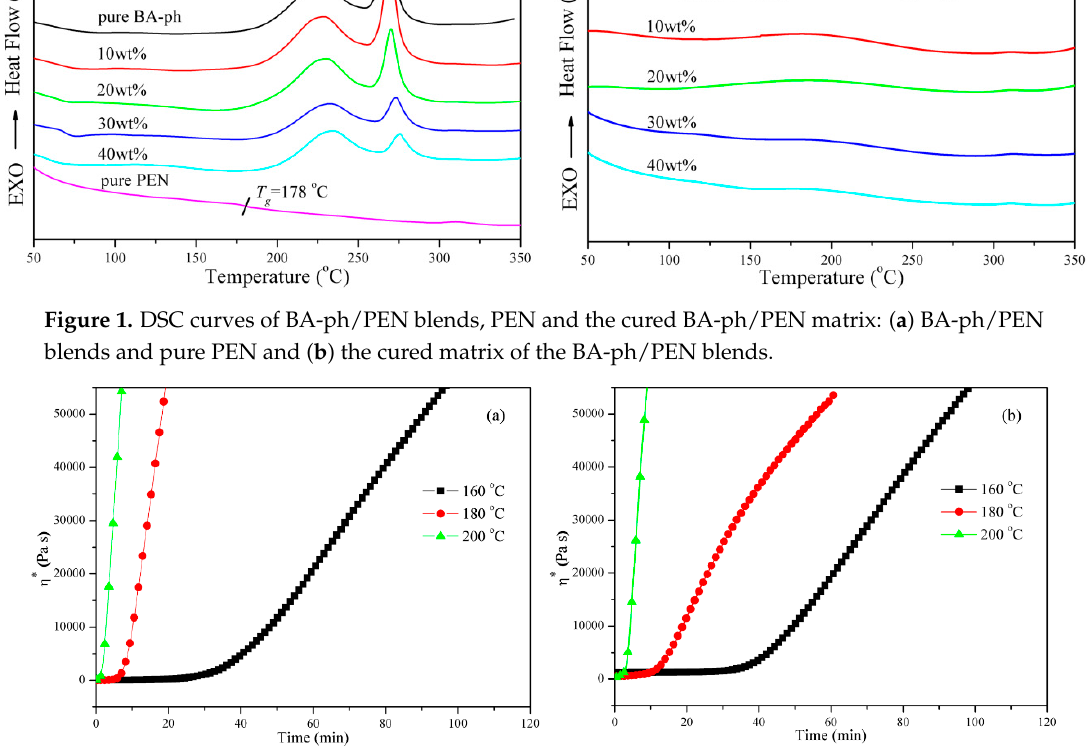
Figure 2. Viscosity of the pure BA-ph and BA-ph/PEN blends with 20 wt % PEN content measured as a function of time at 160 ◦ C, 180 ◦ C and 200 ◦ C: ( a ) pure BA-ph and ( b ) BA-ph/PEN blends with 20 wt % PEN content.